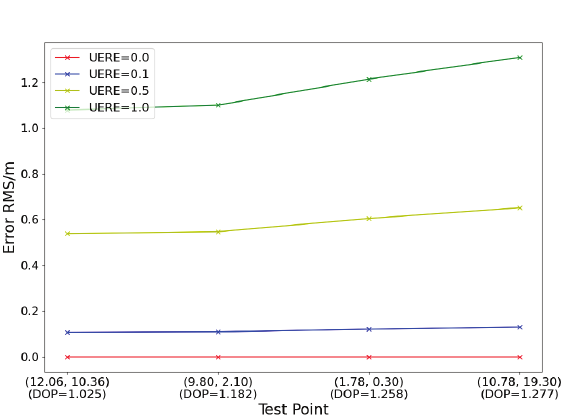
Table 2 . RMS of position errors with four test points and UERE values.